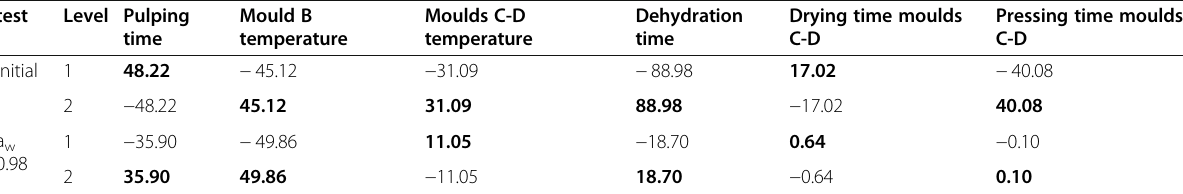
Table 6 Resulting effect for each factor tested on the Young modulus of samples test Level Pulping time